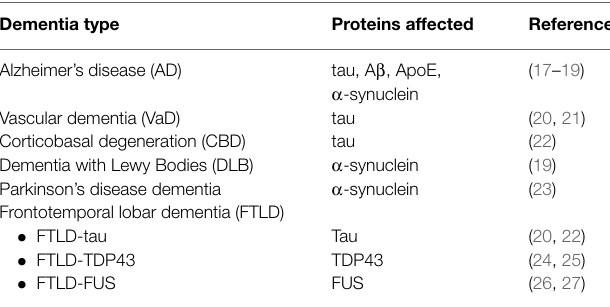
TABLE 1 | Common types of dementia and proteins affected